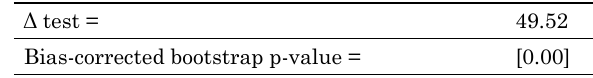
Table 1. Homogeneity